Question: How would you classify this visualization?
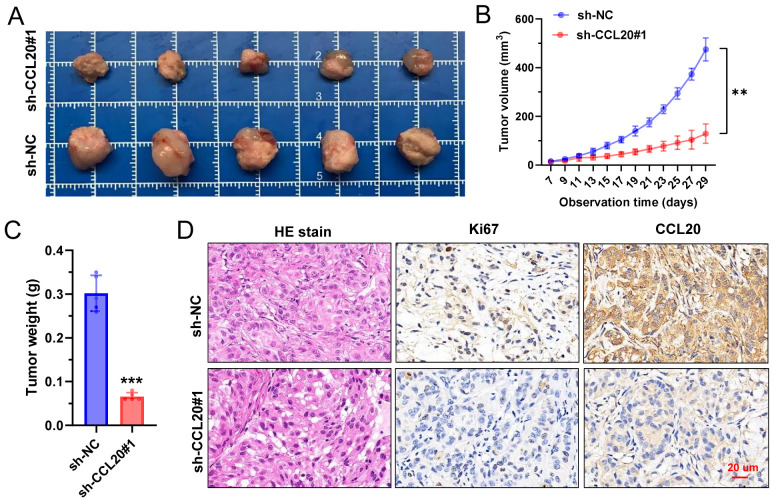
Answer: bar